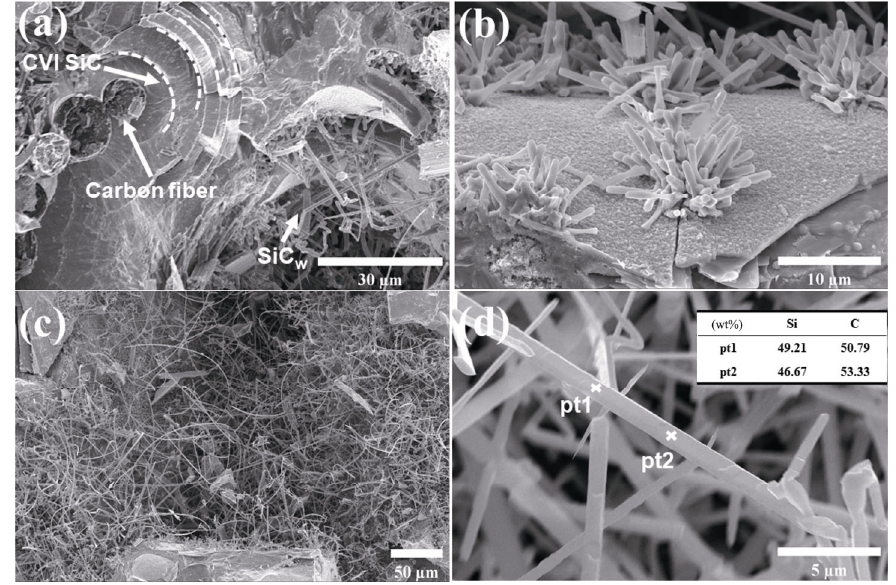
Fig. 4 Microstructures and EDS analyses of SiC w